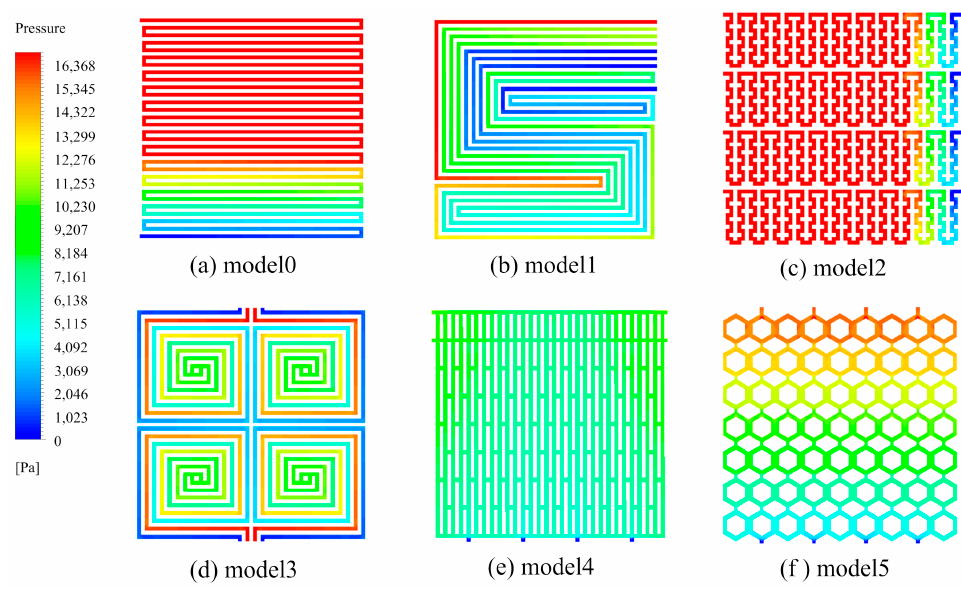
Figure 9. Pressure